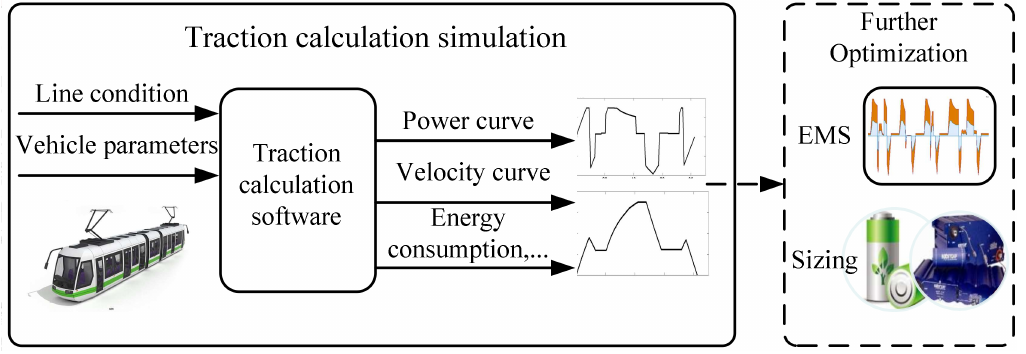
Figure 5. Constitution of tram’s traction calculation